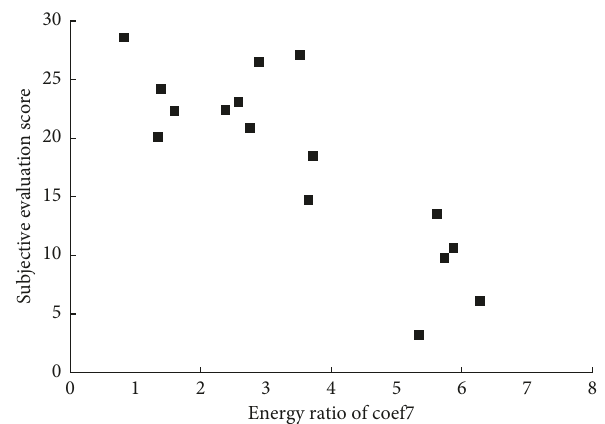
Figure 12: Correlation between the energy ratio coefficient of component 7 and the subjective evaluation value.